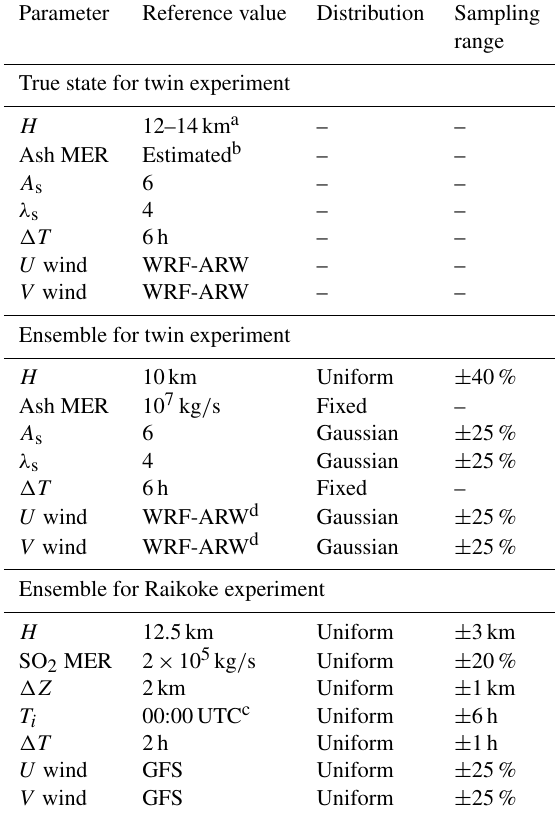
DA experiments that are considered in this work (see Sect.